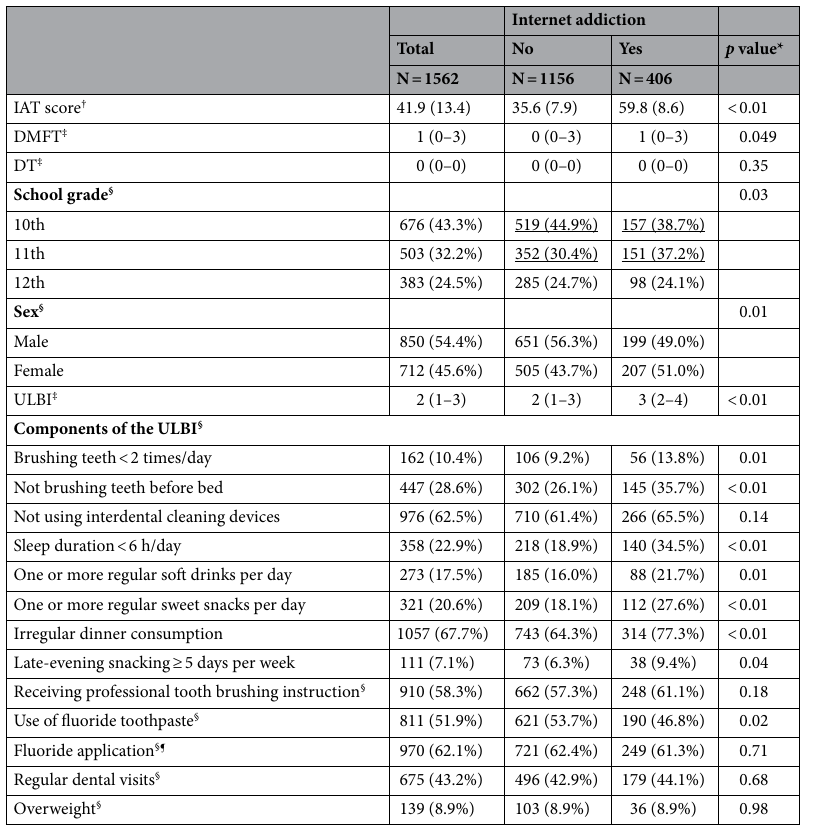
Table 1. Characteristics of the study population according to the presence of internet addiction (N = 1562). IAT Young’s Internet Addiction Test, DMFT number of decayed, missing, and filled permanent teeth, IQR interquartile range, SD standard deviation, ULBI unhealthy lifestyle behavior index. Underlined text indicates data with significant adjusted standardized residuals. *Comparison between groups. † Presented as the mean (SD). ‡ Presented as the median (IQR). § Presented as n (%). ¶ Either a professional topical fluoride application or fluoride mouth